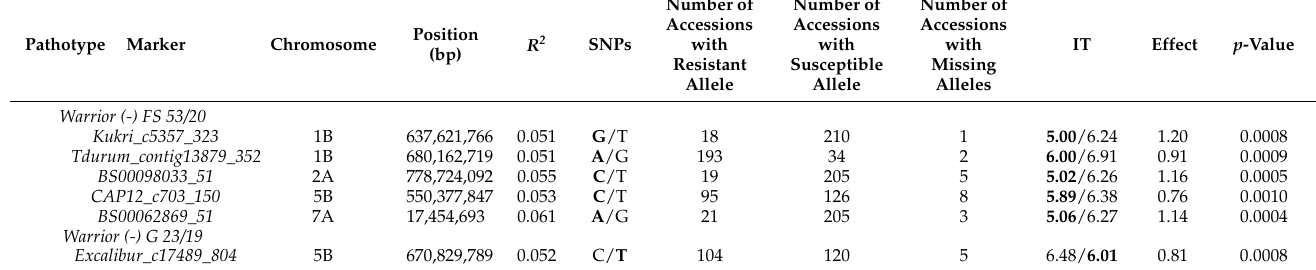
Table 1. SNP markers associated with yellow rust severity (based on IT) for the means of each Pst pathotype. The marker alleles and IT associated with increased resistance are bolded. IT indicates the mean infection type corresponding to the resistant vs. susceptible allele.